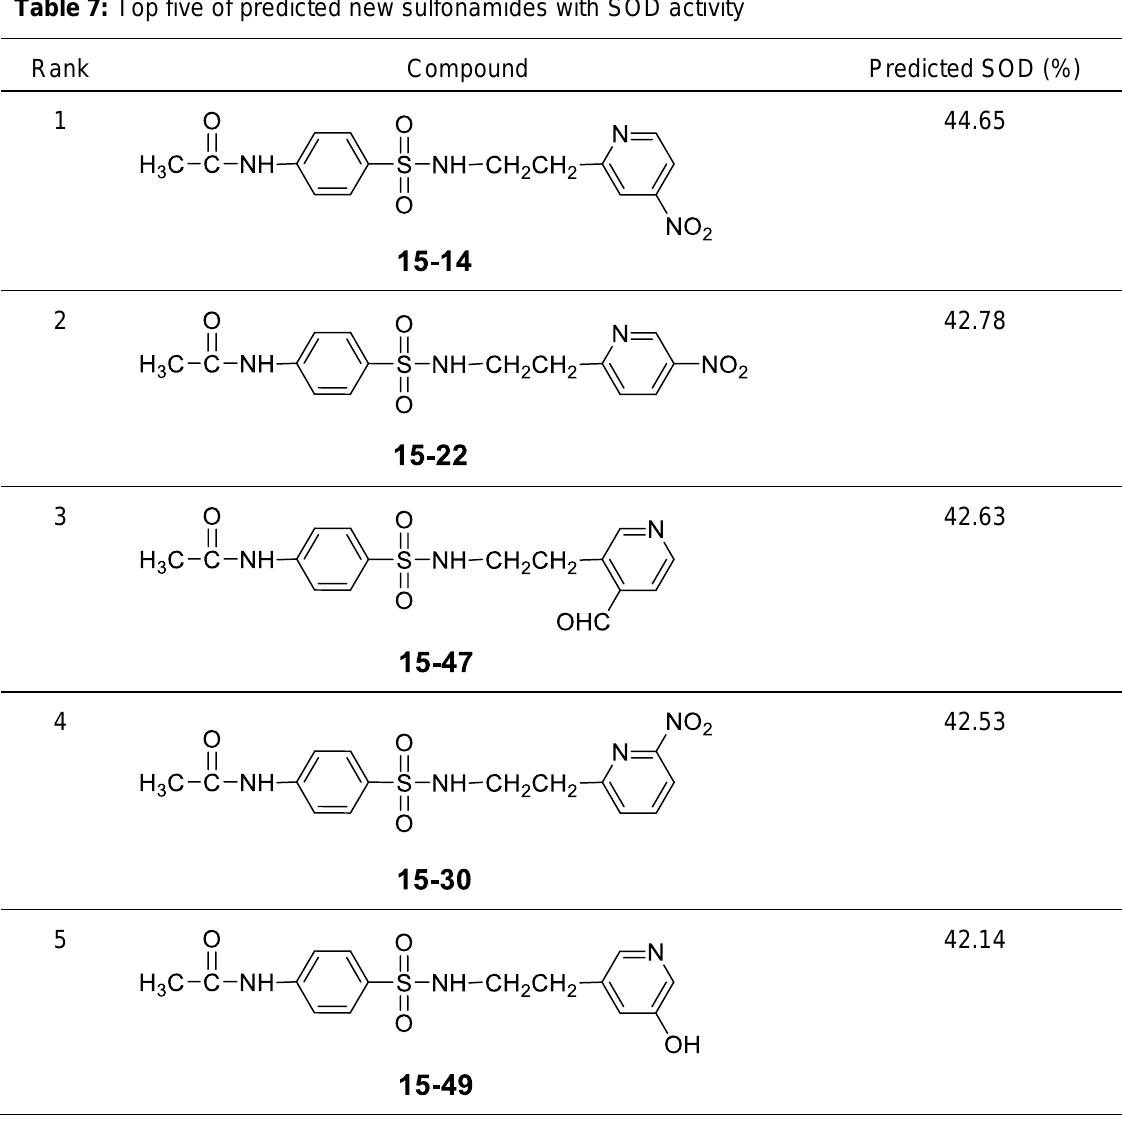
Table 7: Top five of predicted new sulfonamides with SOD activity